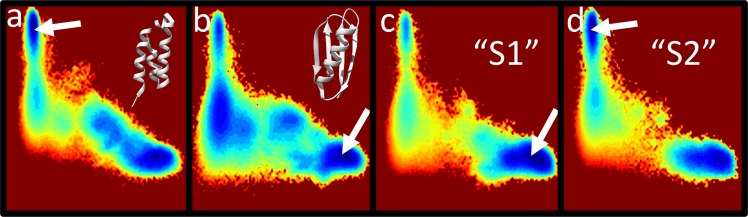
Free energy landscapes of additional switch sequences in the GA/GB system.Plotted in the same style as that in Fig 5. (a) GB98-T25I (PDB:2LHG). (b) GB98-T25I,L20A (PDB:2LHE). PDB structures in (a) and (b) are depicted by the ribbon diagrams. (c) Predicted switch sequence “S1” prefers GB whereas (d) sequence “S2” prefers GA [66]. The arrows mark the global minimum in each of the energy landscapes.